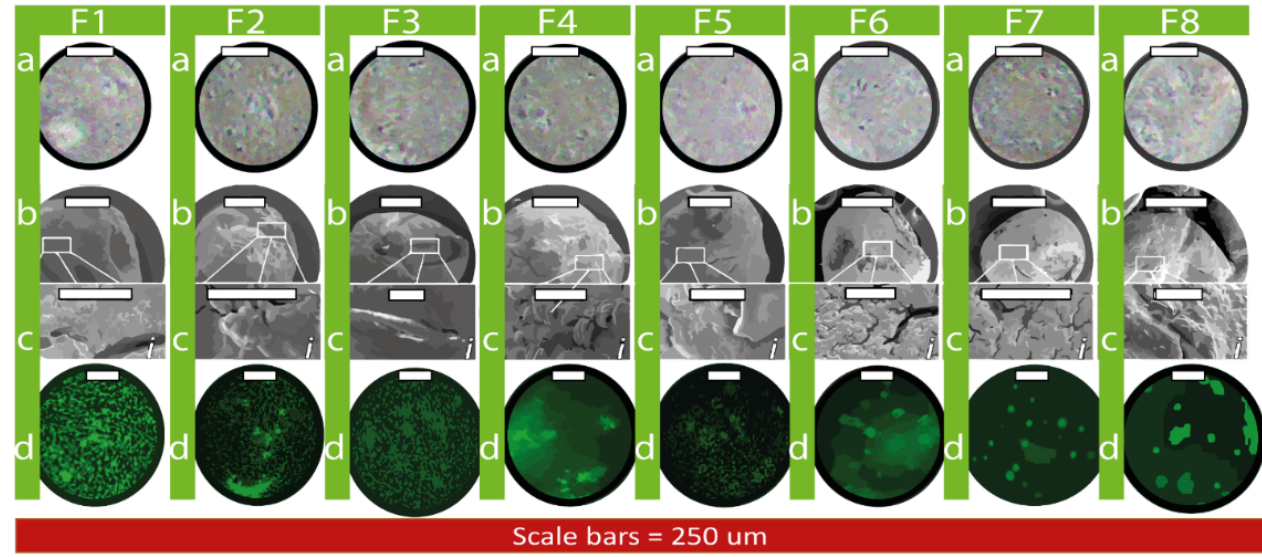
Figure 1. Surface morphology by light microscope ( a ), SEM ( b , c ), and distribution of CFSE-stained cells via confocal microscopy ( d ).